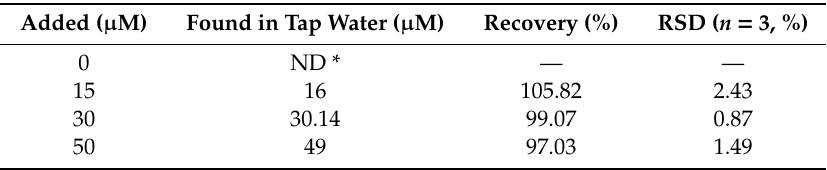
Table 2. Determination of Cu (II) in tap water using